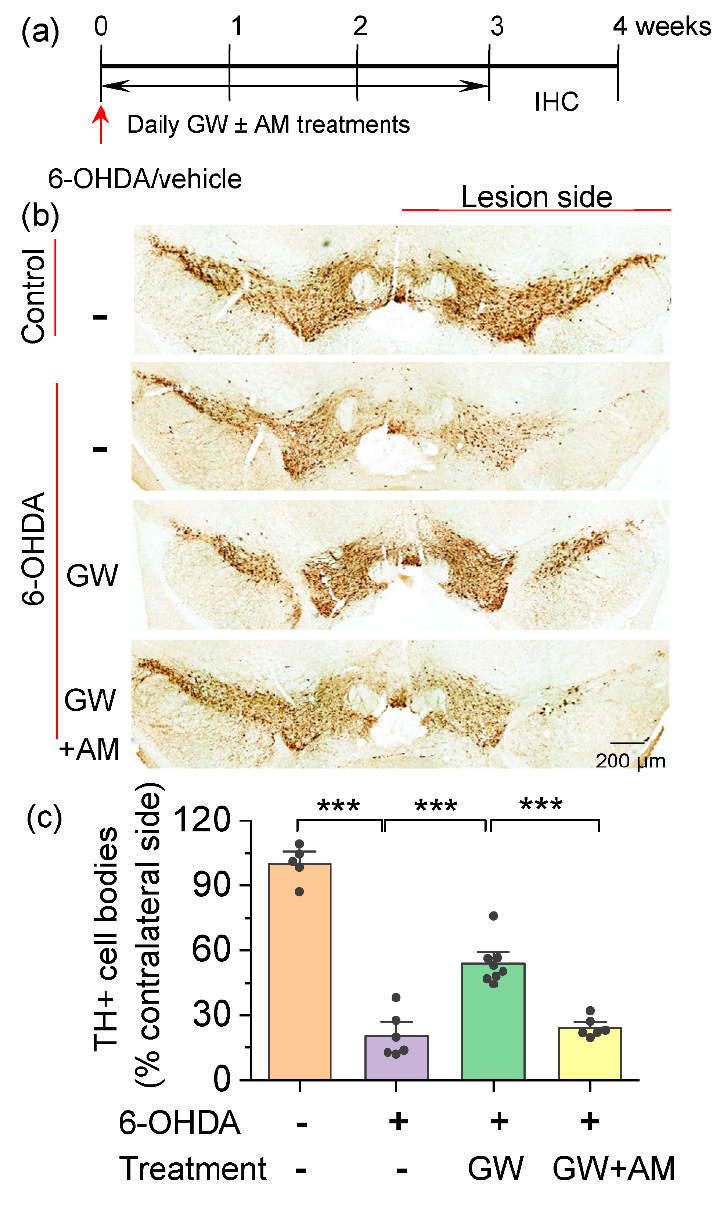
Figure 1. GW842166x (GW) protected against the 6-OHDA-induced loss of dopamine neurons. ( a ) Timeline of 6-OHDA or vehicle injection, GW/AM630 (AM) treatments and histology. ( b ) DAB staining for TH + dopamine neurons in midbrain sections of mice that received intra-striatal injection of 6-OHDA or vehicle and chronic GW or GW + AM treatments. ( c ) Summarized data showing that the total number of TH + dopamine neurons (% if contralateral side) in the SNc was significantly decreased in the 6-OHDA group relative to control (*** p < 0.001, 6 sections/mouse; n = 5–6 mice). Chronic GW treatments reduced 6-OHDA-induced dopamine neuron loss (*** p < 0.001, n = 6–8 mice), and this effect was blocked by co-treatment with AM630 (*** p < 0.001, n = 6–8). 3.2. Mechanisms by Which the CB2 Agonist GW842166x Exerts Neuroprotective Effects The neurodegeneration in PD occurs in SNc dopamine neurons, but the neighboring dopamine neurons in the VTA are largely spared [45]. The selective venerability of SNc dopamine neurons can be attributed to an interplay between high cytosolic dopamine, α - synuclein, and high cytosol Ca 2+ levels [28]. Dopamine release is triggered by action po- tential (AP) firing. SNc/VTA dopamine neurons exhibit autonomous pacemaker firing that is necessary to maintain a basal dopamine tone in their projection targets, including the striatum [29]. In adult SNc dopamine neurons, the autonomous pacemaker firing is driven by the co-activation of hyperpolarization-activated cyclic nucleotide-gated chan- nels (HCN) and L-type (Ca v 1.3) Ca 2+ channels [29,32], leading to a sustained Ca 2+ entry and mitochondrial stress [33]. Compared to SNc dopamine neurons, VTA dopamine neu- rons express a much lower Ca v 1.3 Ca 2+ channel density [46], high levels of the Ca 2+ -buffer- ing protein calbindin [47], and have a significantly lower risk of degeneration in PD